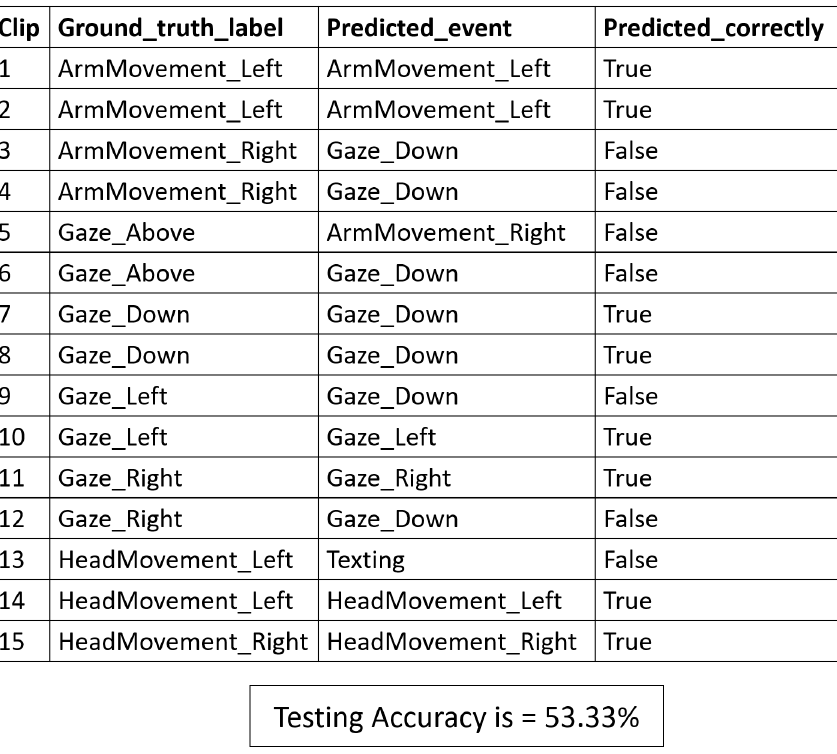
Figure 19. Cheating detection algorithm results in a different